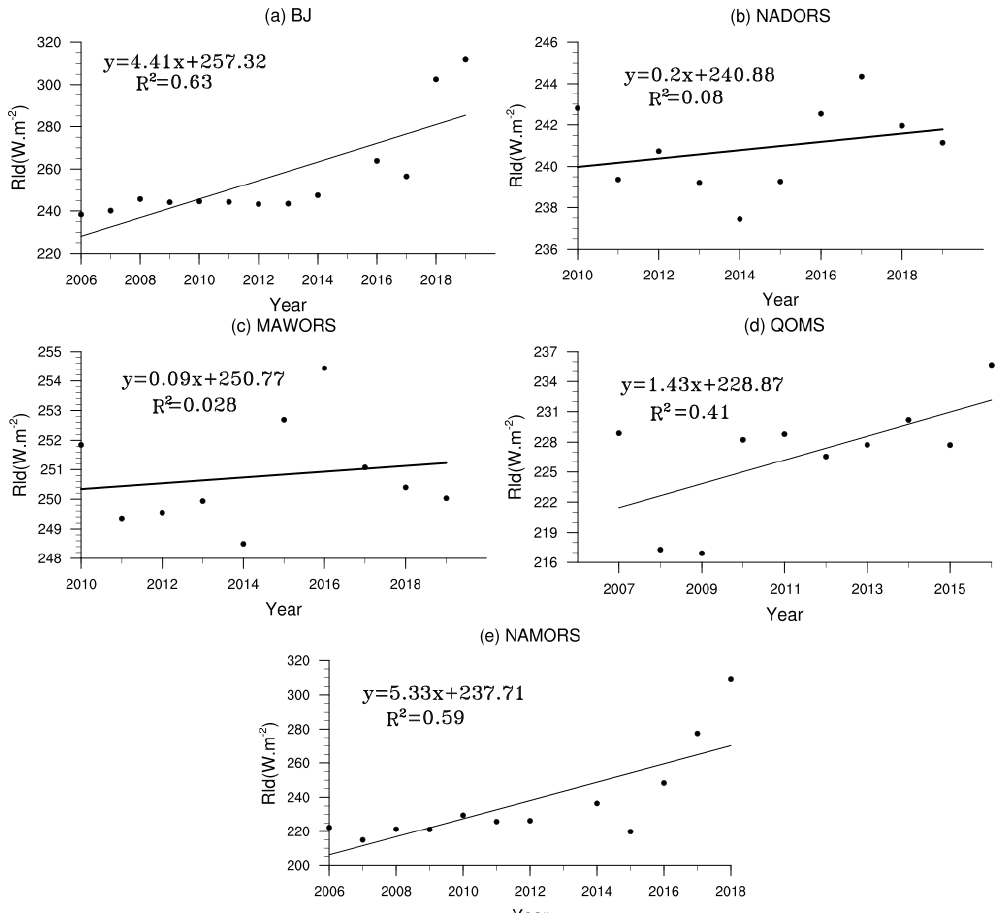
Figure 18. Interannual variation of downward longwave radiation at each station.